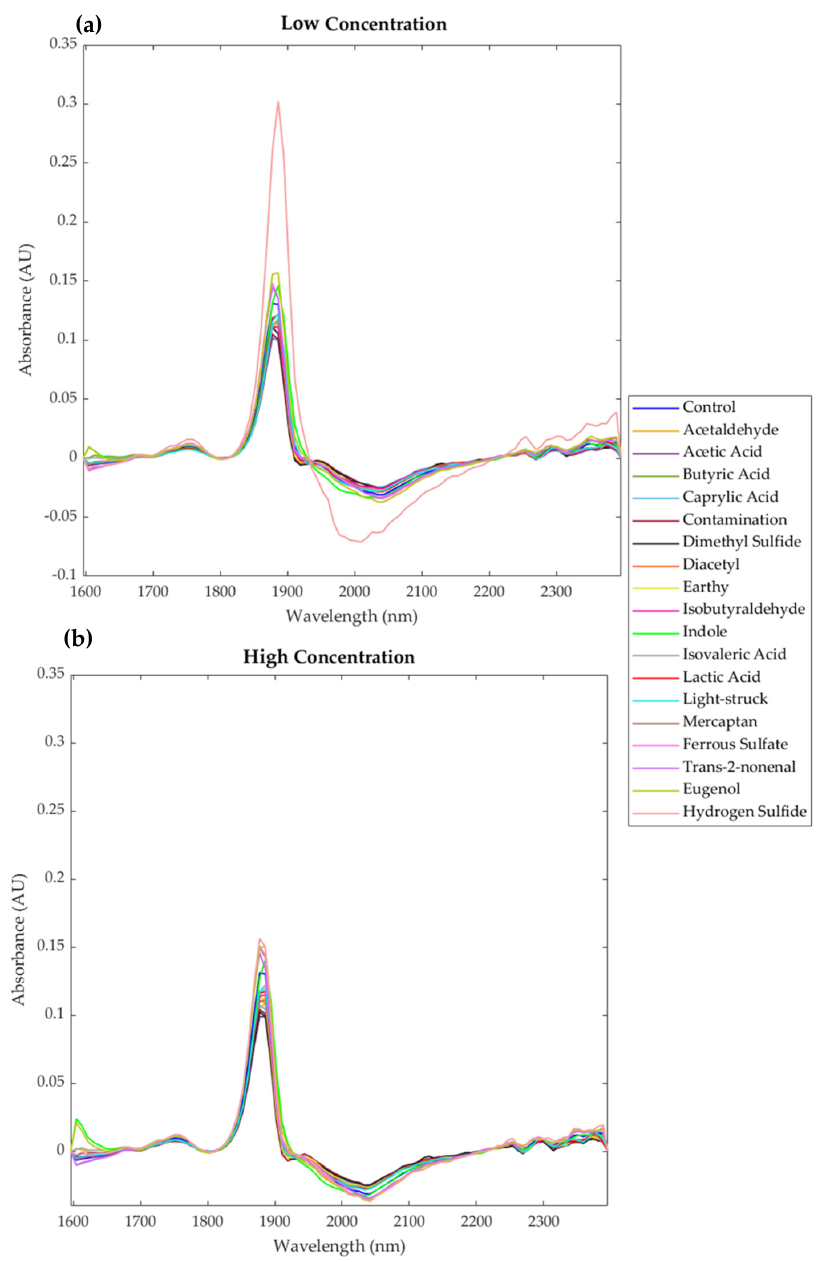
Figure 3. Near-infrared curves for all beer samples using the first derivative of the absorbance values at ( a ) low and ( b ) high concentrations.